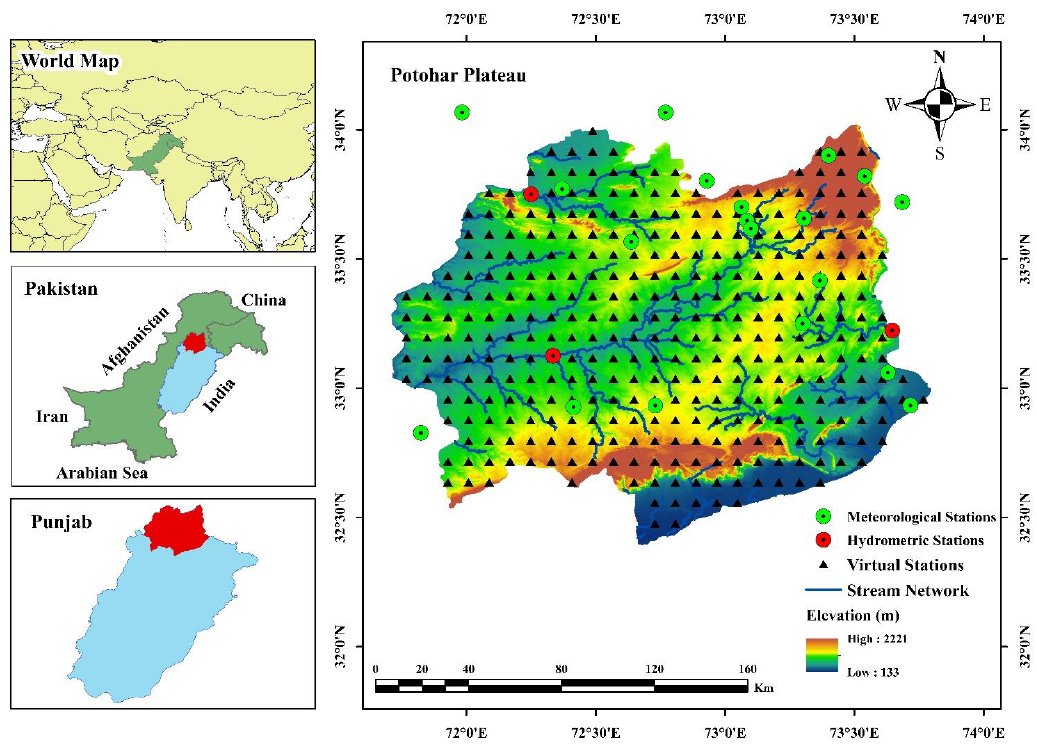
Figure 1. Study area map of the Potohar Plateau with the topography, hydrometric stations, meteorological stations, and gridded virtual stations.